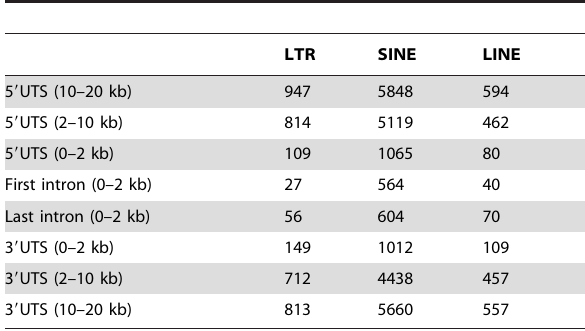
Table 1. The numbers of new TE insertions in each genomic region in mouse and